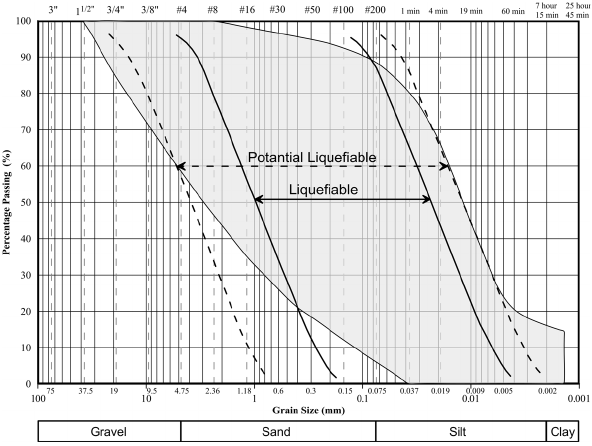
Fig. 7. Grain size distribution range of the soil samples.